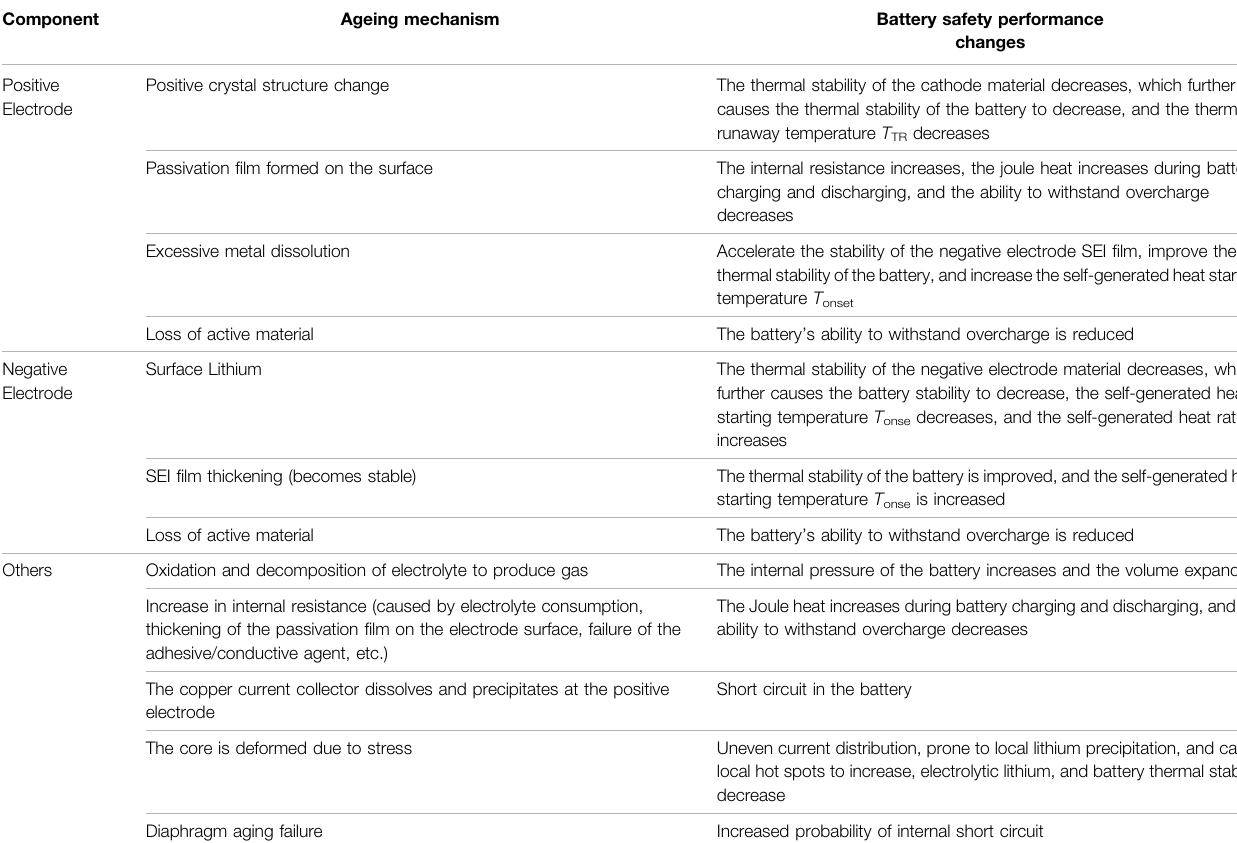
TABLE 1 | Relationship between battery ageing mechanisms and the evolution of safety performance.